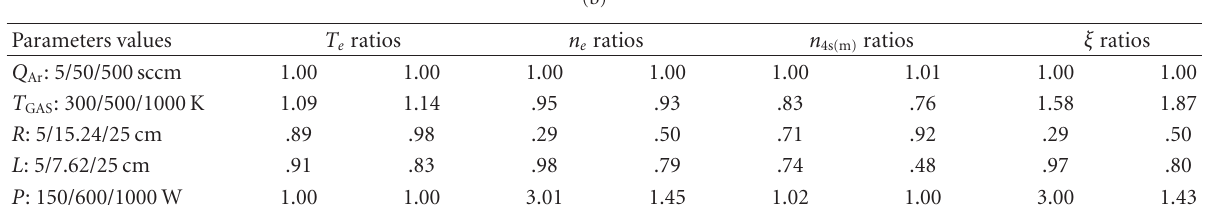
Table 9: Sensitivity of core region plasma parameters, for a pressure of 2.5 mTorr. Presentation of results follows this of Tables 7 and 8. Parameters values